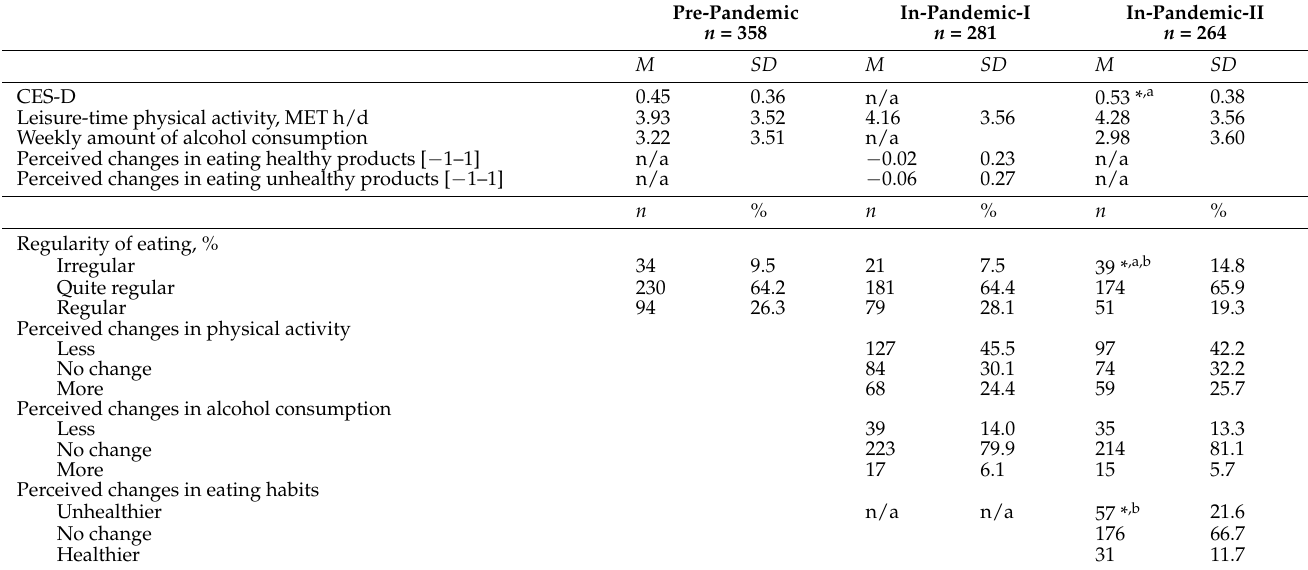
Table 2. Study outcomes at three data collection